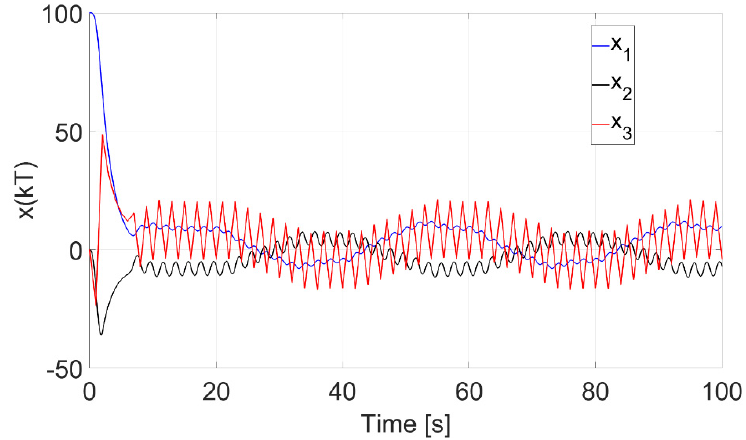
Figure 9. States of the plant controlled by the Gao’s reaching law controller.